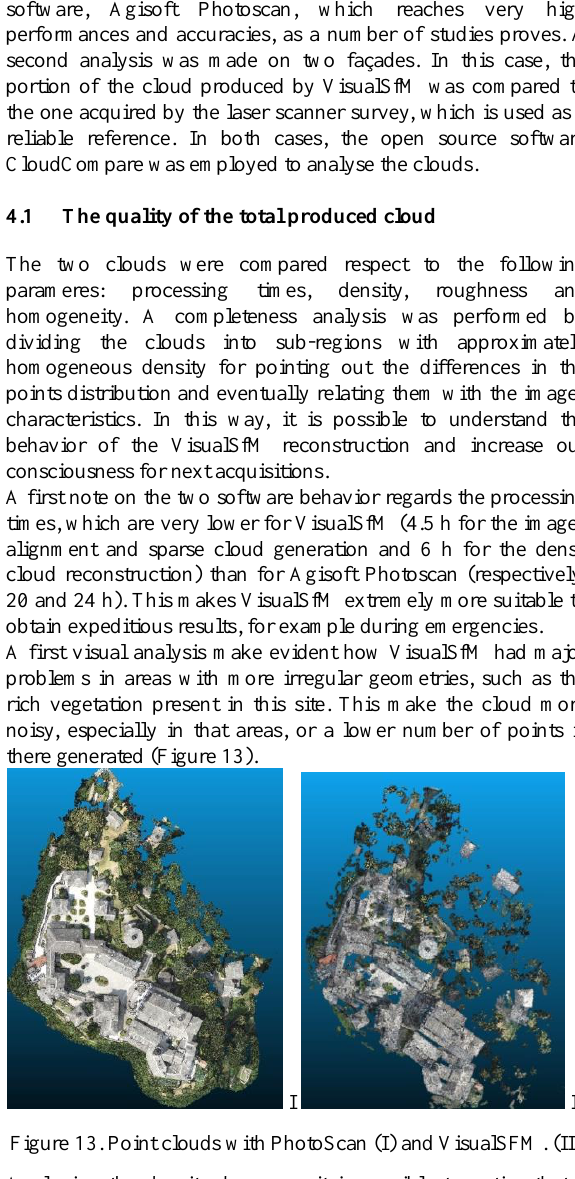
Figure 15. Density analysis on the SfM cloud of a single building: density map on the two sides of the building (I and II) and histogram of the points density